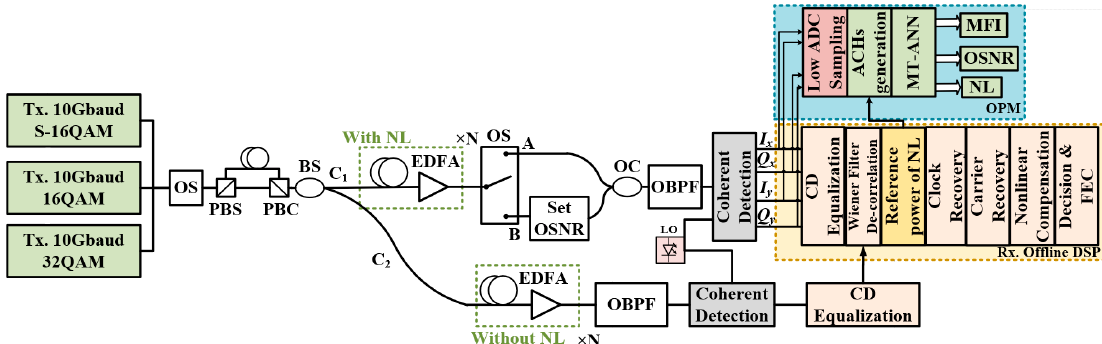
Figure 6. Block diagram of the OPM (MFI, OSNR and NL) based on MT-ANN for an optical fiber transmission system. (PBS: polarization beam splitter, PBC: polarization beam coupler, BS: beam splitter, EDFA: erbium-doped optical fiber amplifier, OS: optical switching, OC: optical coupler, OBPF: optical bandpass filter, LO: local oscillator, ADC: analog to digital